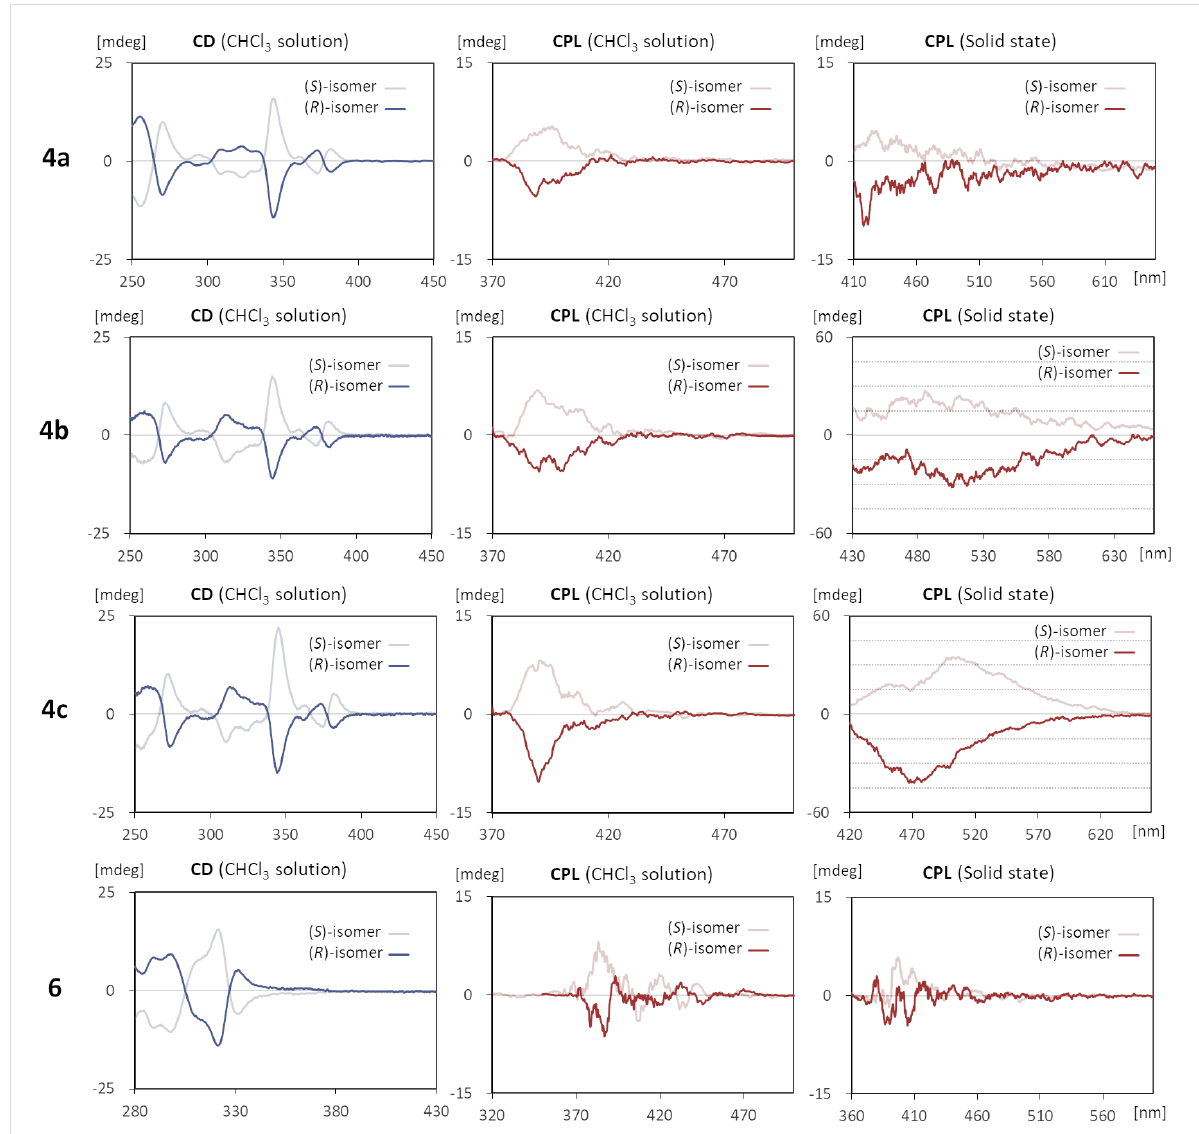
Figure 3: CD and CPL spectra of 4 and 6 measured as CHCl 3 solutions (1.0 × 10 − 5 M) and in solid states (dispersed in Fomblin ® ).